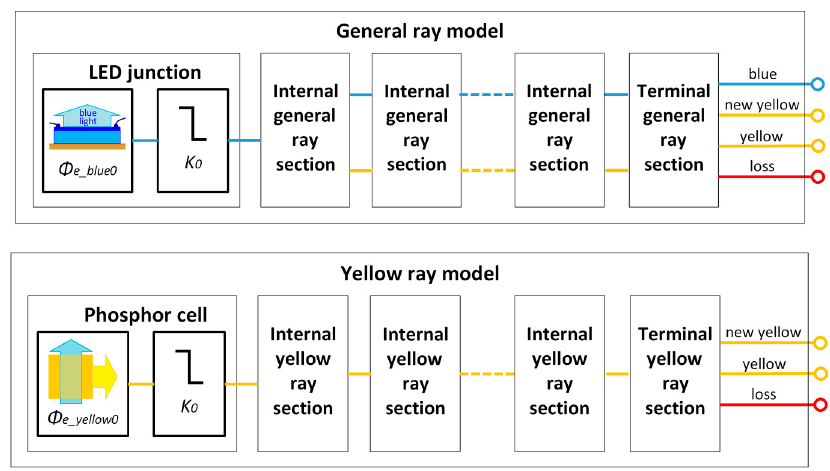
Figure 19. Structure of the ray models. Φ e _ yellow 0 is the sum new yellow of the starting phosphor cell. K 0 is the ratio of the flux treated by the ray to that of the starting cell.